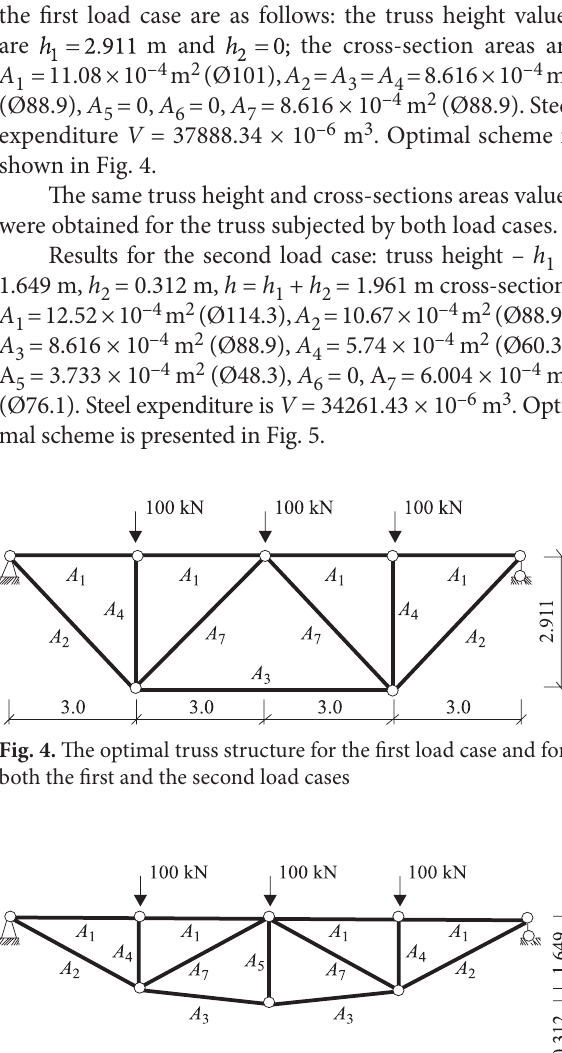
Fig. 5. The optimal truss structure for the second load